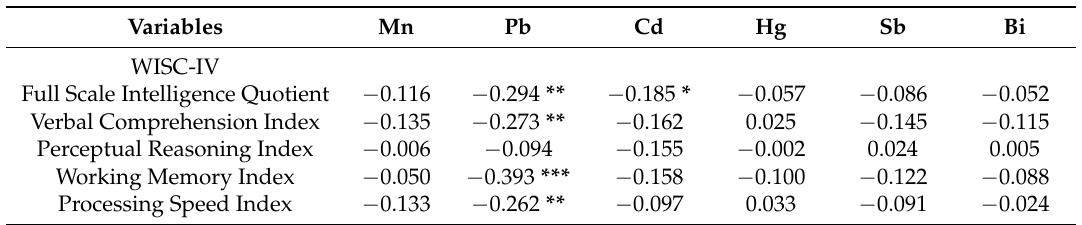
Table 2. Relationship between urinary levels of heavy metals, ADHD clinical symptoms, and Relationship between urinary levels of heavy metals, ADHD clinical symptoms, neuropsychological functions among all participants ( n = 122). and neuropsychological functions among all participants ( n =